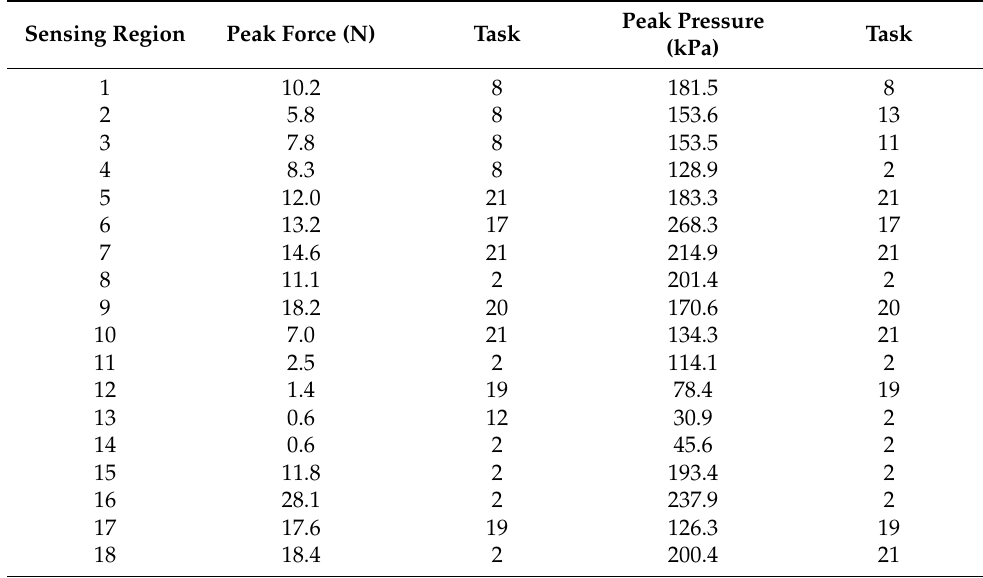
Figure 10. Linear correlation coefficient between tasks ( a ) and between regions ( b ), based on the CGF of the eighteen sensing regions. Table 4. Maximum peak force and peak pressure in the sensing regions, averaged among subjects, with indication of the task in which they